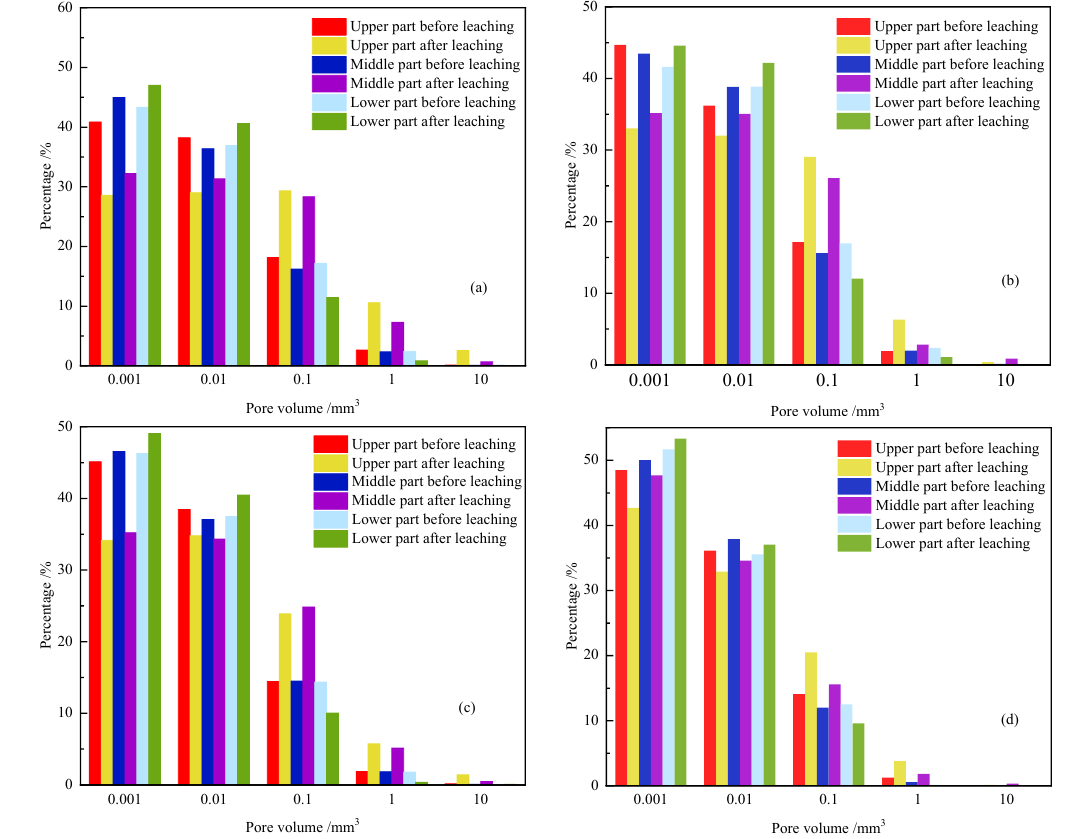
Figure 7. Distribution rules of the pore volume of ore samples at different depths before and after leaching. ( a ) A D = 2 . 03 ; ( b ) B D = 2 . 23 ; ( c ) C D = 2 . 43 ; ( d ) D D = 2 . 63 .